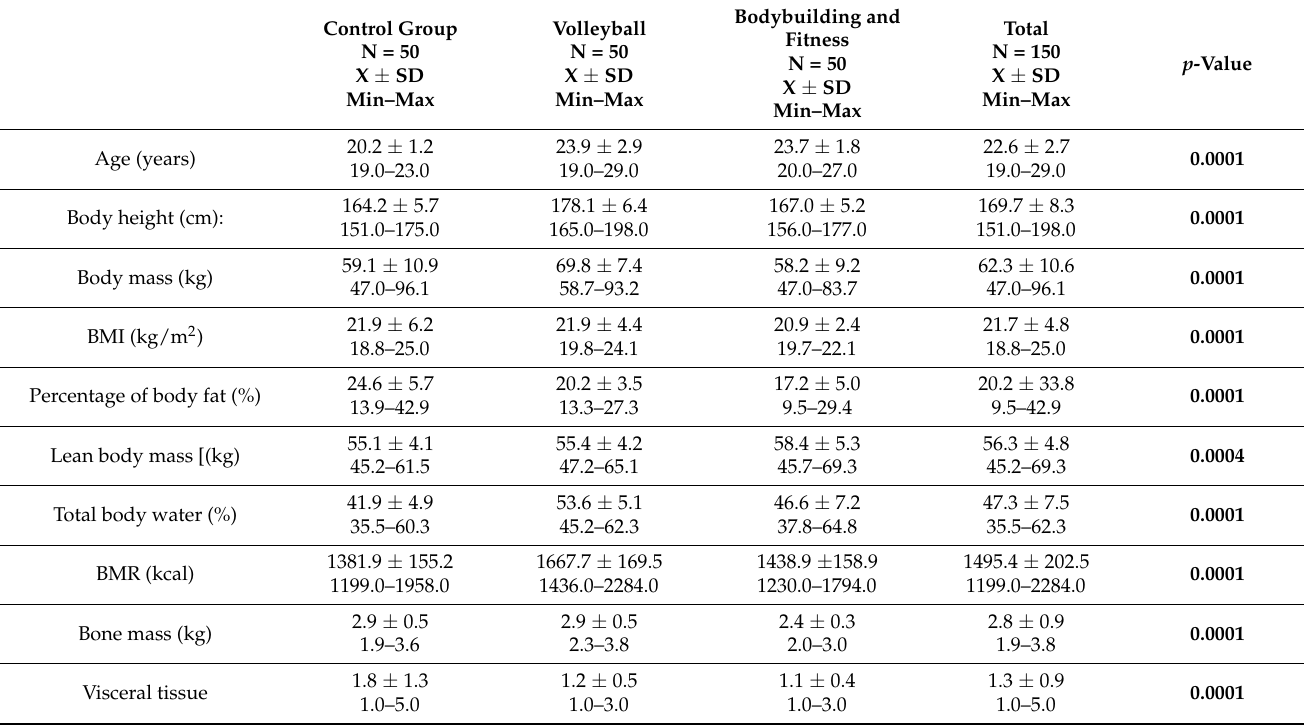
Table 2. Characteristics of the study group and body composition analysis.